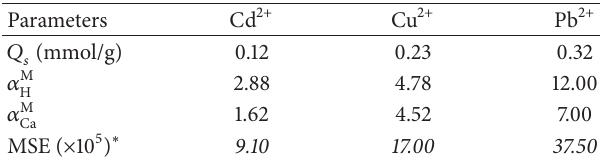
∗ MSE: mean squared error.